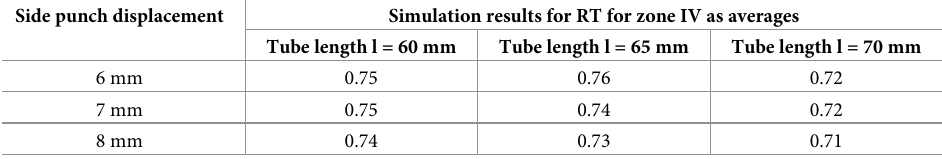
Table 5. Simulation results for minimum RT in zone IV.